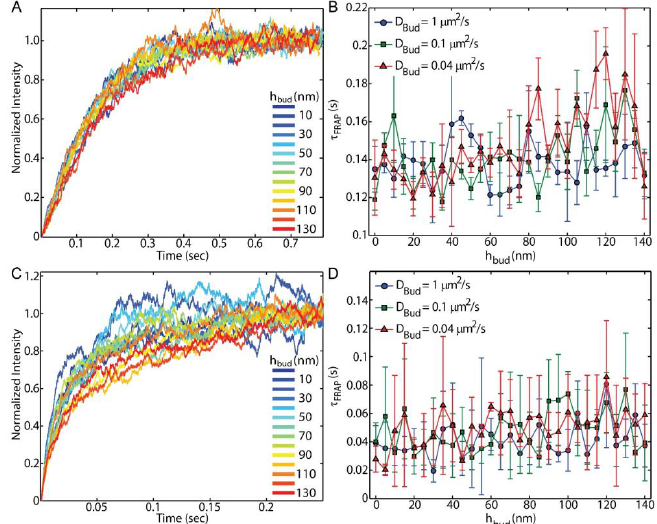
Figure 2. Increasing the bud height does not result in significant changes to the fluorescence recovery after photobleaching (FRAP) recovery time, including when the lipid diffusion was slowed to D Bud = 0.1 or 0.04 μm 2 /s on the curved membrane for both ( A , B ) complete bleaching and ( C , D ) Gaussian Bleaching; ( A , C ) Simulated I ( t ) traces while D Plane = 1 μm 2 /s and D Bud = 0.1 μm 2 /s shows the recovery of I ( t ) after bleaching. There was no apparent trend in the recovery rate changing with bud height; ( B , D ) The recovery rate was quantified by fitting Equation (2) to find τ FRAP from I ( t ) of each condition. Error bars represent the standard error of the mean between four repeated simulations.